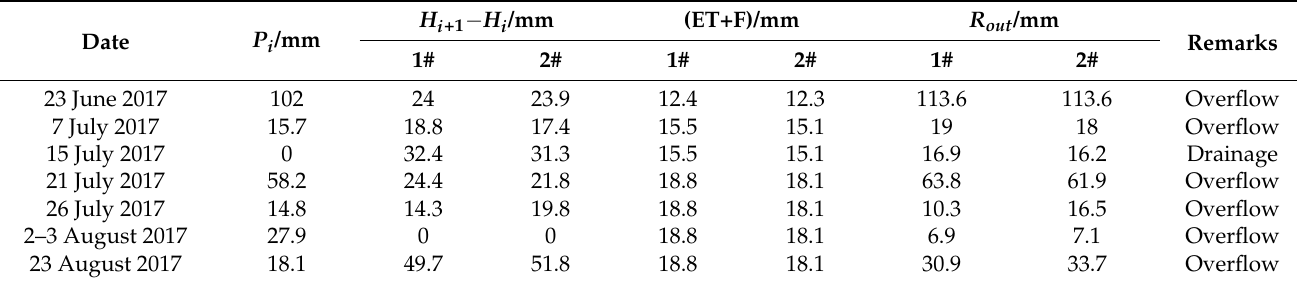
Table 2. Calculated results of outflow between data for points 1# and 2#.